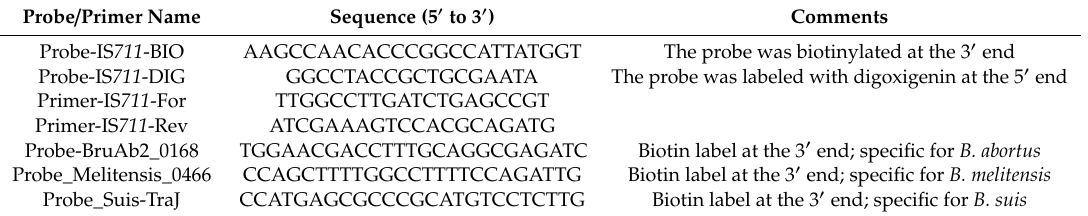
Table 1. Oligonucleotide probes and primers used for detecting major Brucella nomenspecies.